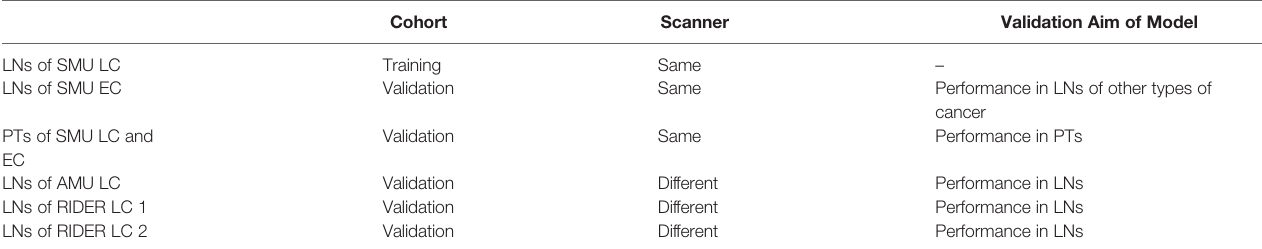
TABLE 1 | Training and validation cohorts.